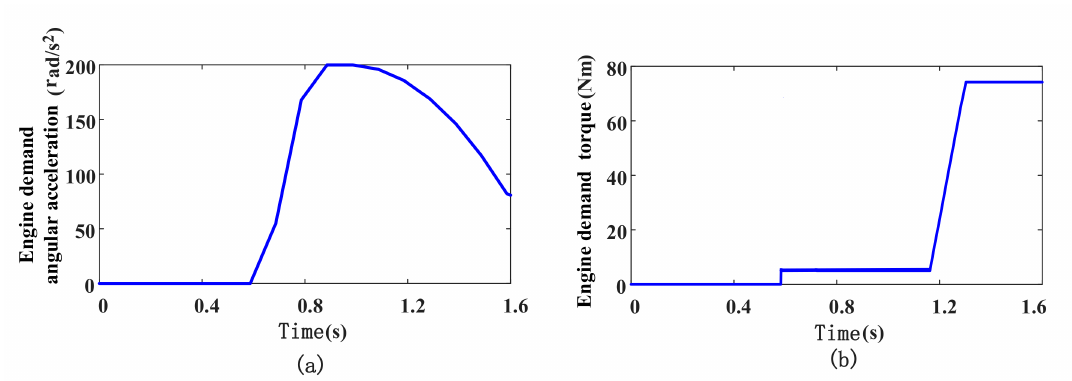
Figure 5. Engine demand variables:( a ) engine demand angular acceleration; ( b ) engine demand